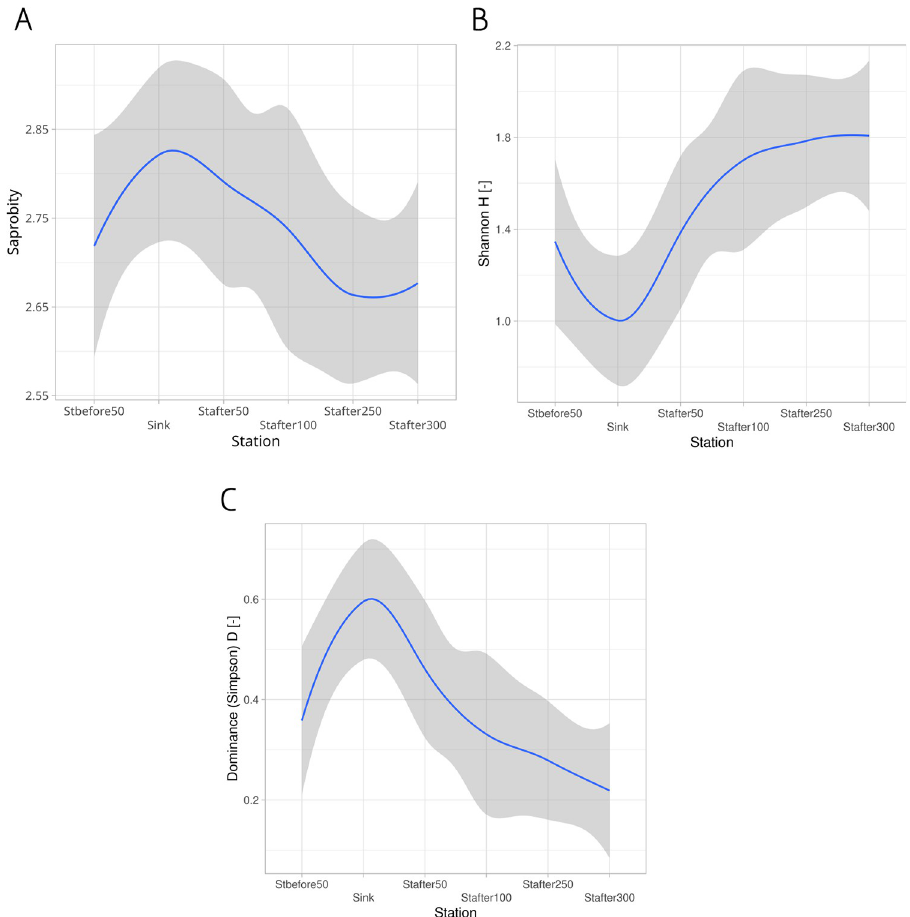
Fig 6. Changes in selected indicators of biodiversity by stations in an environmental gradient based on data for the entire study period. Blue line–loess regression line, gray area– 95% confidence band for loess regression line. (A) Changes in the Pantele-Buck saprobity index. (B) Changes in the Shannon’s index. (C) Changes in the Simpson’s dominance index.